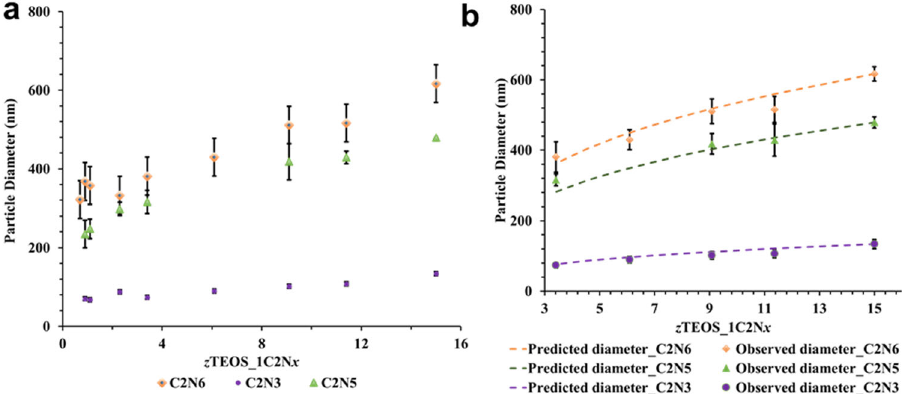
Fig. 2 Bioinspired silica synthesis using polyamines of different chain lengths and at varying z TEOS_1C 2 N x mole ratios. a Average diameter of silica particles produced in presence of constant polyamine concentration of 22 mM at 60 °C (error bars represent stand deviation); b Observed and predicted (dashed line) average diameters of silica particles grown at higher z TEOS_1C 2 N x mole ratios, z = 3.4 – 15). Average diameters were calculated from SEM images by measuring 100 particles using an in-house MATLAB script (error bars represent standard